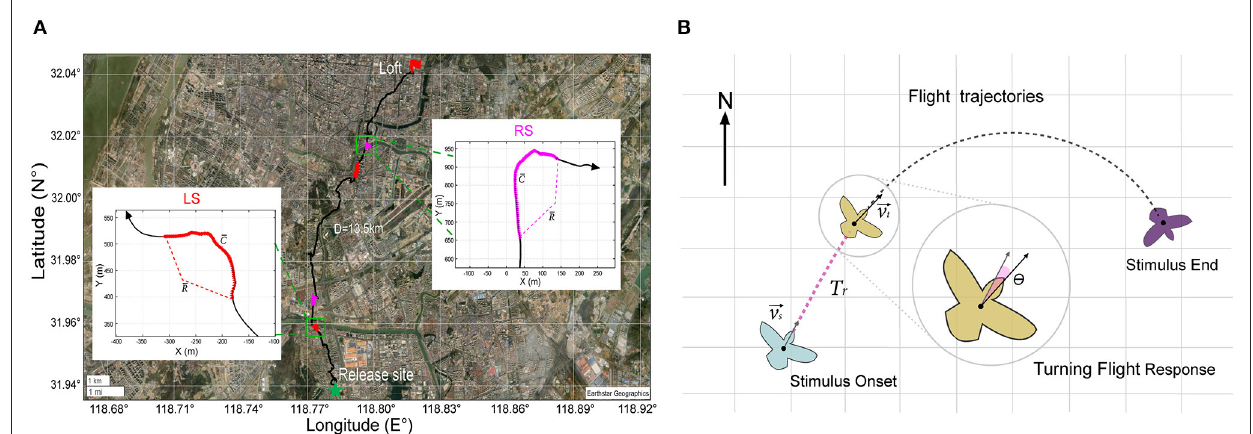
FIGURE3 GPS data analysis during turning flight of robo-pigeon. (A) Example of stimulated turning flight of a robo-pigeon. The green star denotes the place where the robo-pigeons were released and the red flag was the loft of pigeons. The straight distance between the release site and the loft is over 10km. Different colors represent different flight trajectories, the black line denotes the flight trajectories of the robo-pigeon without stimulation; the red line denotes the flight trajectories with the stimulation to the left-FRM (LS); the magenta line denotes the flight trajectories with the simulation to the right-FRM (RS). The insets within figures the show the flight trajectory of the robo-pigeon when it was stimulated right and then left FRMs, respectively, under the Universal Transverse Mercator projection coordinate system. V denotes the average speed of flight during the phase of stimulation, C denotes the average curvature of turning during the phase of stimulation, and R denotes the average radius of flight during the phase of stimulation. (B) The turning flight variables were calculated from the turning flight trajectories of the robo-pigeon after being stimulated. The light blue, brown, and purple cartoons represent, respectively different turning flight states of the robo-pigeon. Where −→ v s denotes the flight speed vector at the stimulus onset and −→ ν t was the flight speed vector at the beginning of the turn. The response time of the robo-pigeon’s turning flight behavior was denoted as T r and the turning angle after being stimulated was denoted by θ